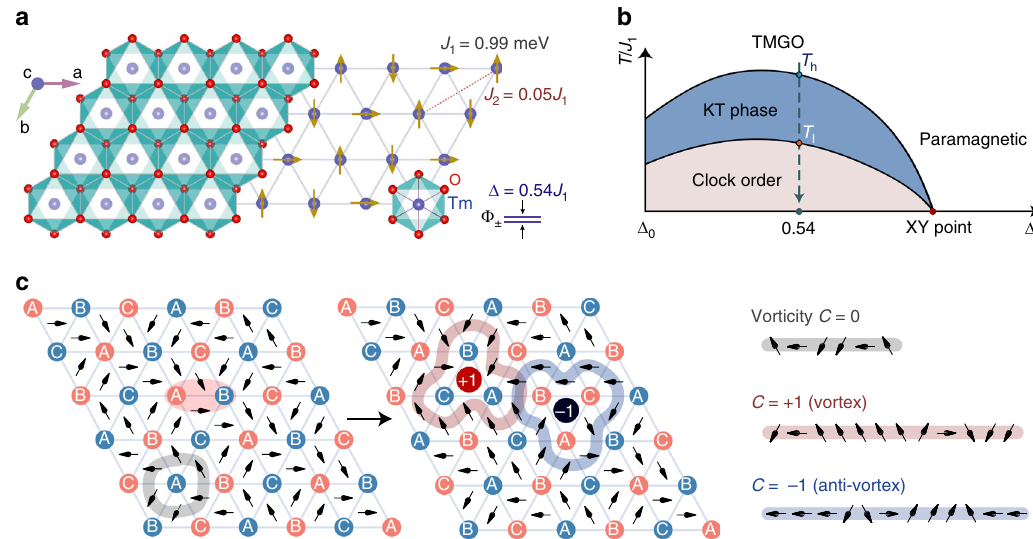
Fig. 1 The crystal structure, phase diagram, and spin texture in quantum magnet TMGO. a The Tm 3 + ions, with an energy splitting Δ between two lowest non-Kramers levels | Φ ± i constitute an effective spin-1/2 model on the triangular lattice, with J 1 and J 2 interactions. An illustration of spin structure in the clock phase is provided, where the spin-up and spin-down arrows are along the magnetic easy c -axis and the horizontal arrow stands for superposition of spin up and down, i.e., !j i . b The schematic phase diagram of quantum TLI model, there exists a quantum critical point on the horizontal axis with emergent spin XY (i.e., U(1)) symmetry, which extends into an intriguing KT phase at fi nite T . Δ > Δ 0 stands for transverse fi elds where the clock order is stabilized in the ground state, in the J 1 – J 2 model with small J 2 coupling. The vertical arrowed line along Δ = 0.54 J 1 represents the TMGO material, with two KT transitions at T h and T l , respectively. c The magnetic stripe order, with the red sites for spin up ( m z = 1 ∕ 2) and blue ones spin down ( m z = − 1/2) on three sublattices A, B, and C. The pseudo spins, i.e., complex order parameters ψ in Eq. (2), are plotted as arrows rotating within the plane, and a vortex-antivortex pair is created by fl ipping simultaneously two spins within the red oval in the left subpanel. As tracked along the paths (exemplary paths are indicated in the plot), topological charge C = ±1, corresponding to 2 π clockwise/counterclockwise angle, emerges when the pseudo spins wind clockwise around the vortex/antivortex, and zero vorticity appears when counting the pseudo-spin winding of both (or no defect at